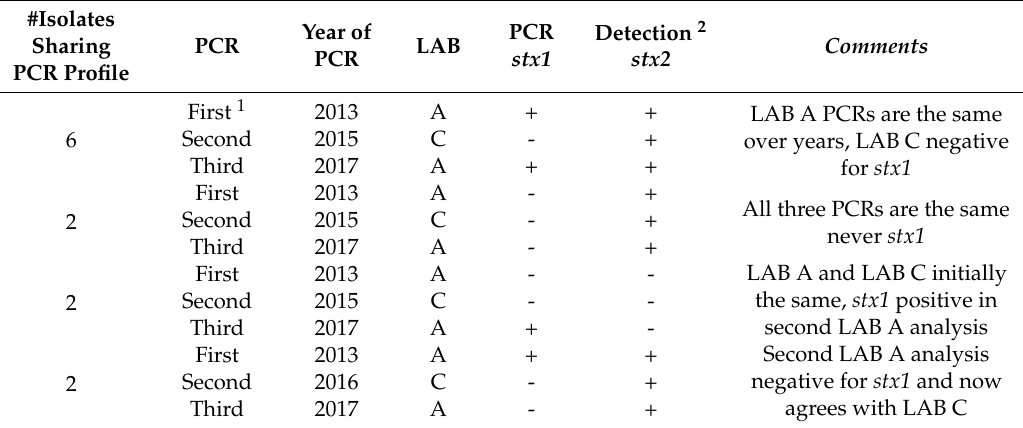
Figure 1. Comparison of PCR primers used by LAB A, Conrad et al. [10] and LAB C, Lin et al. [7] for consensus with sequences of stx2 subtypes. Table 5. Changes in carriage of stx1 and consistent detection of stx2 in twelve isolates of O121:H19 from PCR analysis by two labs.